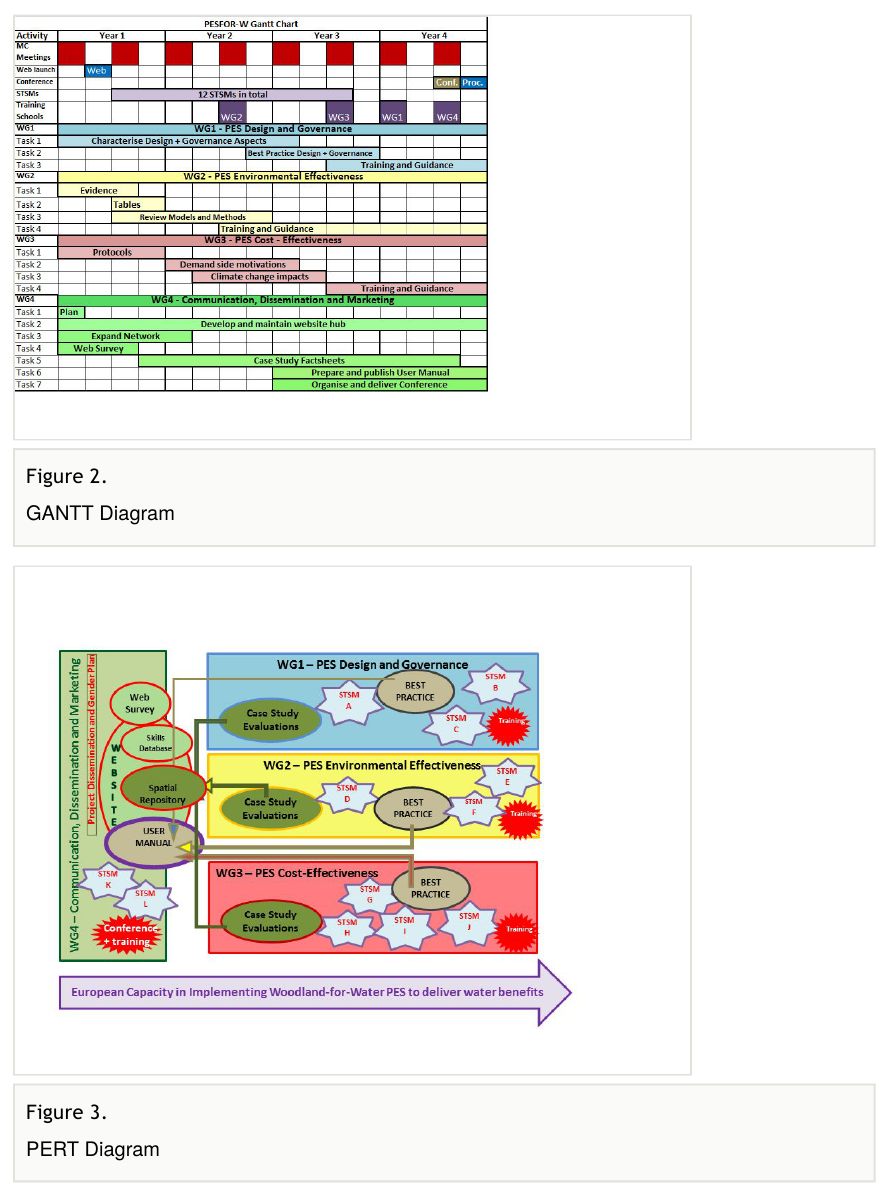
Risk (3) Network fails to achieve required scale and impact – Mitigated by strong Secondary Proposers and their associated networks: Proposers engage in many relevant EU and international projects and networks (per the subsection on the added value of networking in relation to existing e ff orts at European and/or international level), which will act as “leverage multipliers”. Proposers have in-house communications professionals with good knowledge of social media (blogs/Twitter/Facebook) and other networks (including COST O ffi ce and EU science communication channel